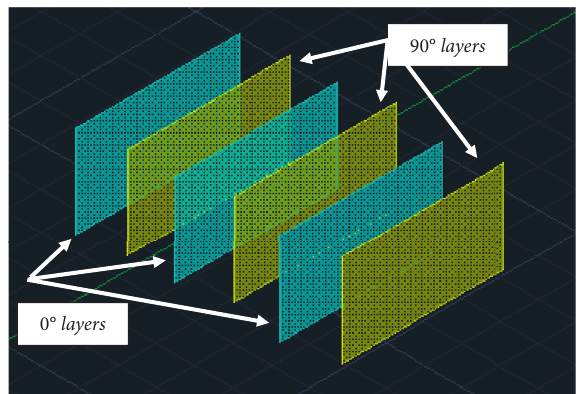
Figure 2: Composite with six